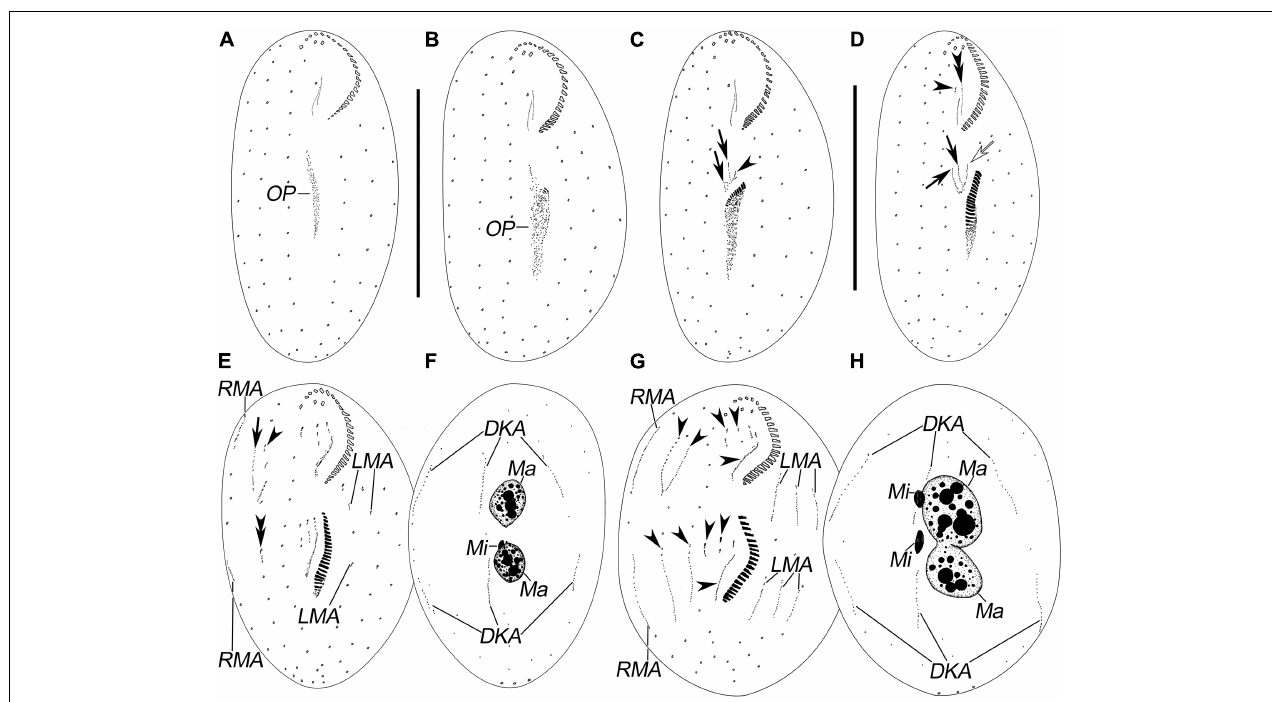
FIGURE 2 | Morphogenesis of Pseudosincirra longicirrata nov. gen., nov. comb. after protargol staining. (A,B) Ventral views of very early dividers showing the newly formed oral primordium. (C) Ventral view of an early divider; arrows mark the FVT-anlagen and arrowhead points to the undulating membranes anlage. (D) Ventral view of a slightly later phase; arrows display the FVT-anlagen, hollow arrow denotes the undulating membrane anlage, and arrowhead and double arrowhead mark the dedifferentiation of buccal cirrus and the parental paroral and endoral, respectively. (E,F) Ventral and dorsal views of a later divider; the arrow shows anlage V in the proter, arrowhead denotes anlage IV in the proter, and double arrowhead marks anlage V in the opisthe. (G,H) Ventral and dorsal views of a cell in prometaphase; arrowheads demonstrate the anlagen I–V in the proter and opisthe, respectively. DKA, dorsal kinety anlagen; FVT-anlagen, frontoventral-transverse cirral anlagen; LMA, left marginal anlagen; Ma, macronuclear nodules; Mi, micronuclei; OP, oral primordium; RMA, right marginal anlagen. Scale bars = 100 µ m.